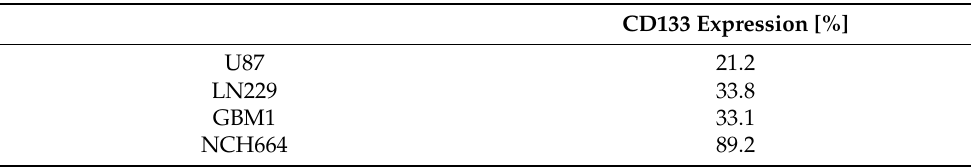
Table 1. The percentage of CD133 expression in different tumor cell